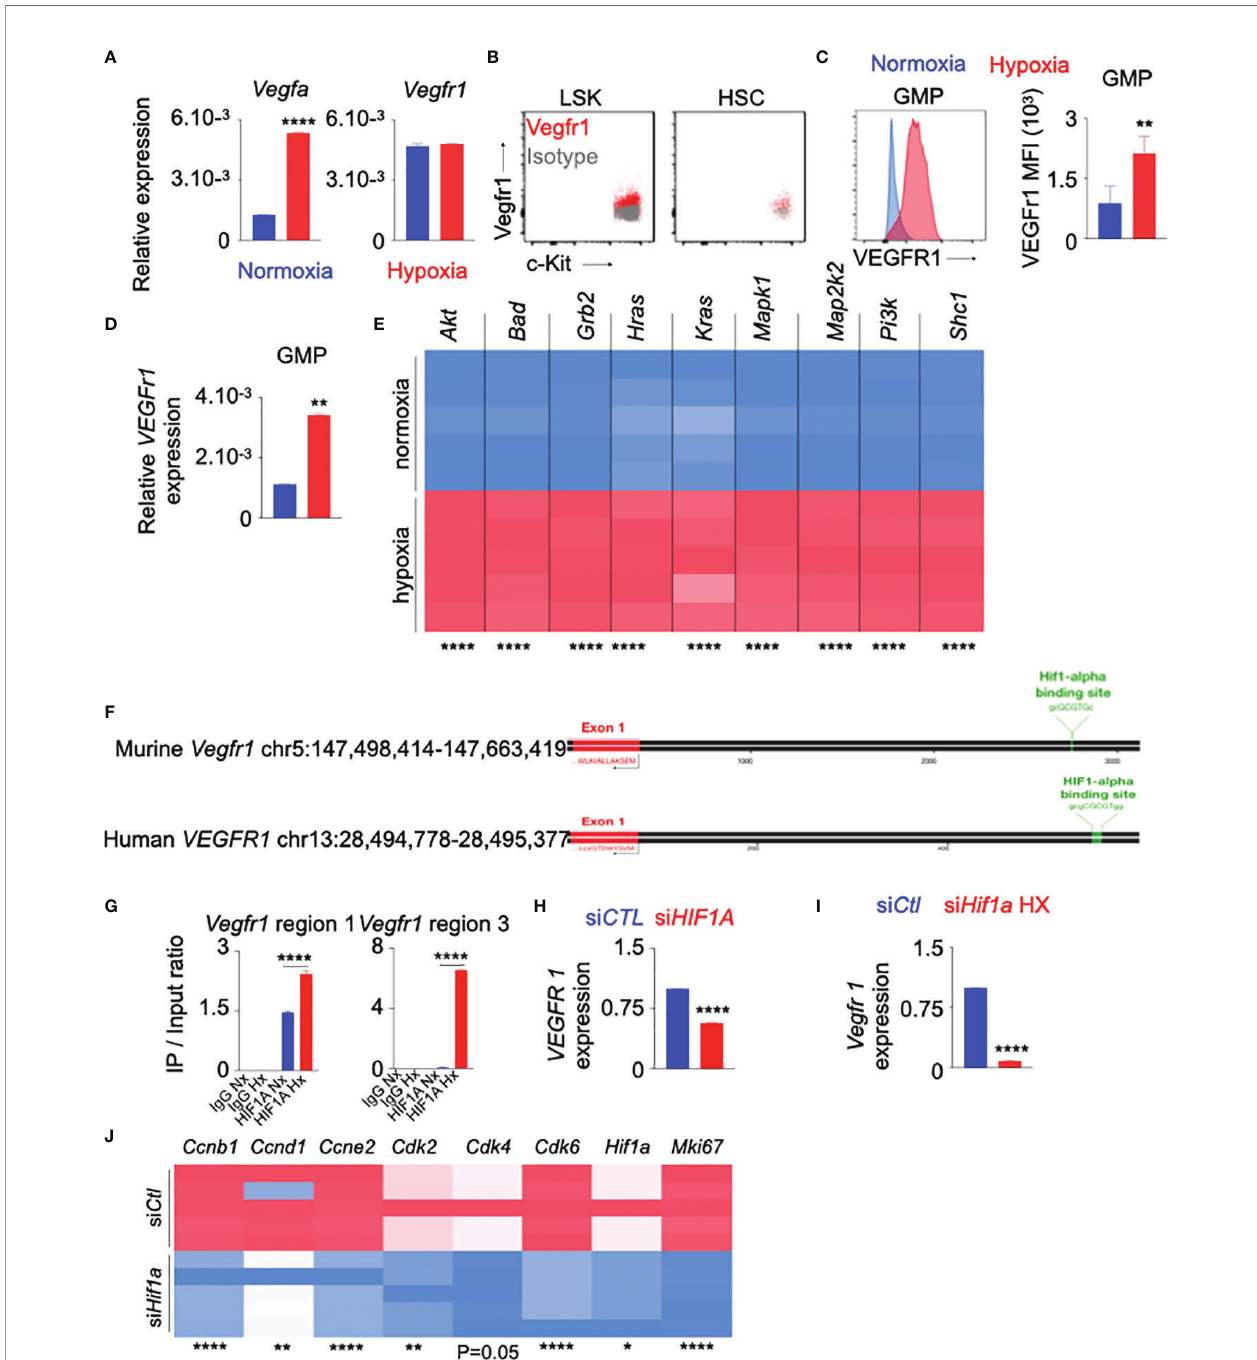
FIGURE 3 | VEGFr1 expression is increased in HSPC in hypoxia. (A – C) C57BL/6 mice were placed under either normoxic or hypoxic conditions for 21 days. Bone marrow was collected. (A) Vegfa and Vegfr 1 expression in the whole bone marrow was assessed by RT-qPCR. B – C) Vegfr 1 expression was measured in bone marrow LSK and HSC in normoxic conditions (B) and GMP in normoxic and hypoxic conditions (C) by fl ow cytometry. The results are represented as mean fl uorescent intensity (MFI). (D) Vegfr 1 gene expression was measured in sorted GMP by RT-qPCR. (E – G) HSPC were sorted from bone marrow of C57BL/6 mice and cultured in complete SFEM media in either normoxic or hypoxic conditions. (E) Heatmap representing expression of the genes downstream to Vegf/Vegfr 1 in HSPC cultured under normoxic and hypoxic conditions. (F) Schematic depicting HIF-1 a binding sites on both murine and human VEGFr 1 promoter regions. (G) Con fi rmation of the binding of HIF-1 a to the murine Vegfr 1 promoter region assessed by ChIP qPCR. (H, I) VEGFr 1 expression assessed in human (H) and murine (I) HSPC transfected with either si CTL or si HIF1A in hypoxic conditions. (J) Heatmap showing the expression of the cell cycle genes in HSPC transfected with either si Ctl or si Hif1a in hypoxic conditions. n = 5 mice per condition (A – D) , 5 replicates per condition (E – J) . Data are shown as mean ± s.e.m. *P < 0.05, **P < 0.01, ****P <